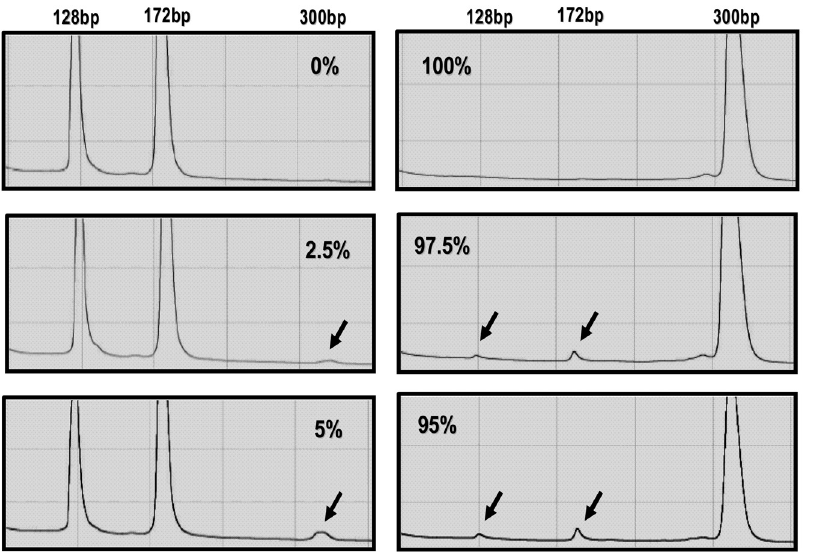
Figure 4. Chromatograms obtained for HPLC separation of digested samples with known heteroplasmy levels (PARFAH Method).